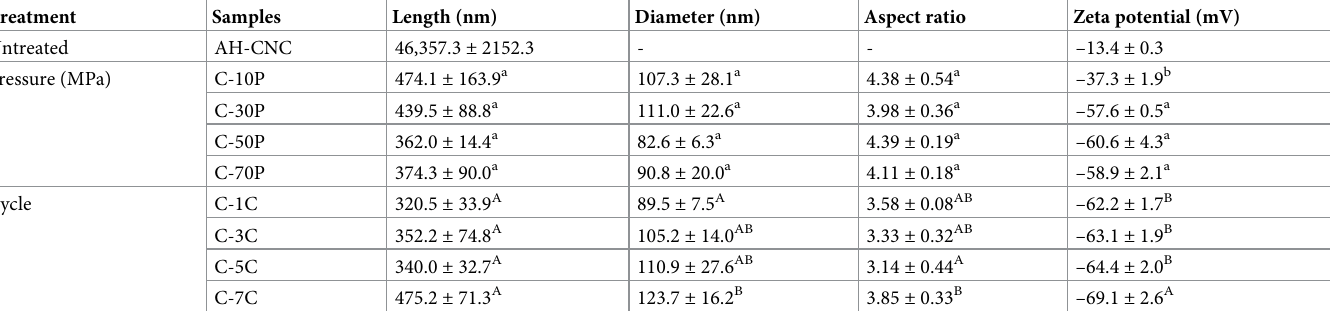
Table 2. The length, diameter, aspect ratio and zeta potential of CNC treated by different homogenisation pressures and